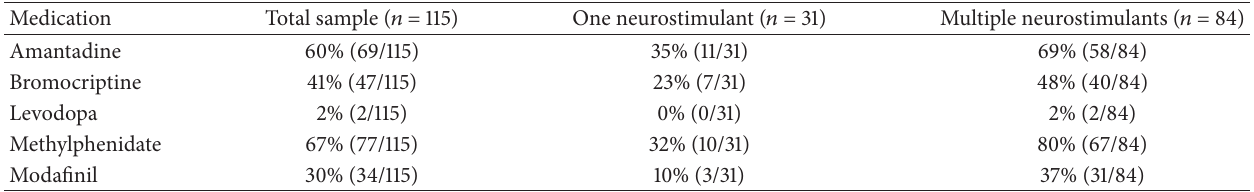
Table 2: Neurostimulant medications prescribed during